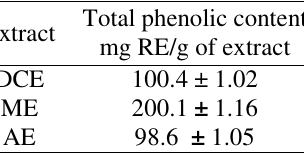
Table 1. Total phenolic content of extracts of Andrographis stenophylla leaf (Readings are average of three determinations).